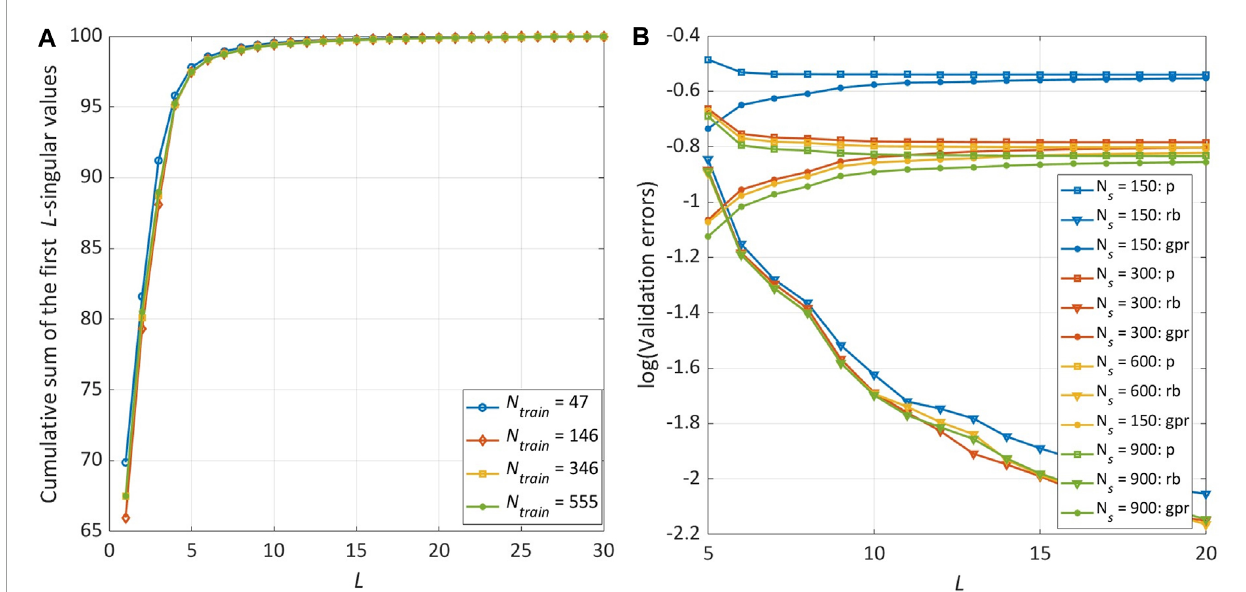
FIGURE 6 Sensitivity analysis on the number of RBs ( L ) and the training database size ( N train ) . The results are obtained using the Bézier curve parameters ( μ B ) as GPR predictors. (A) Percentage of variance of the snapshots matrix ( S ) explained by the first L components of the SVD. (B) Evolution in logarithmic scale of AE rb , AE p and AE gpr